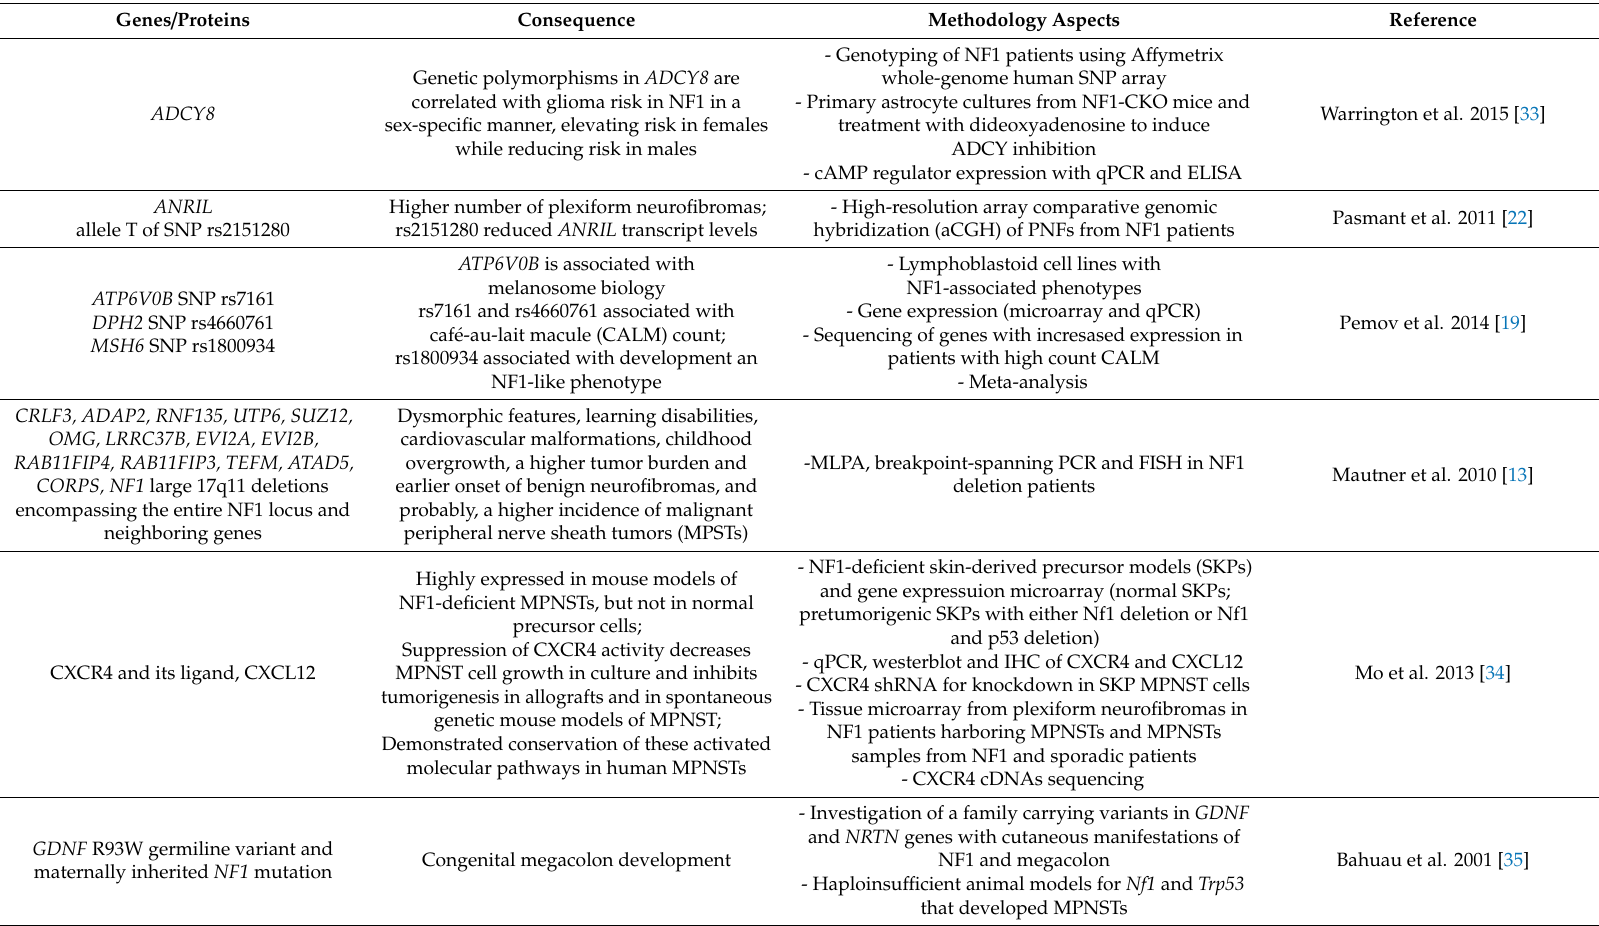
Table 4. List of genes and proteins previously described as NF1 phenotype modifiers in the